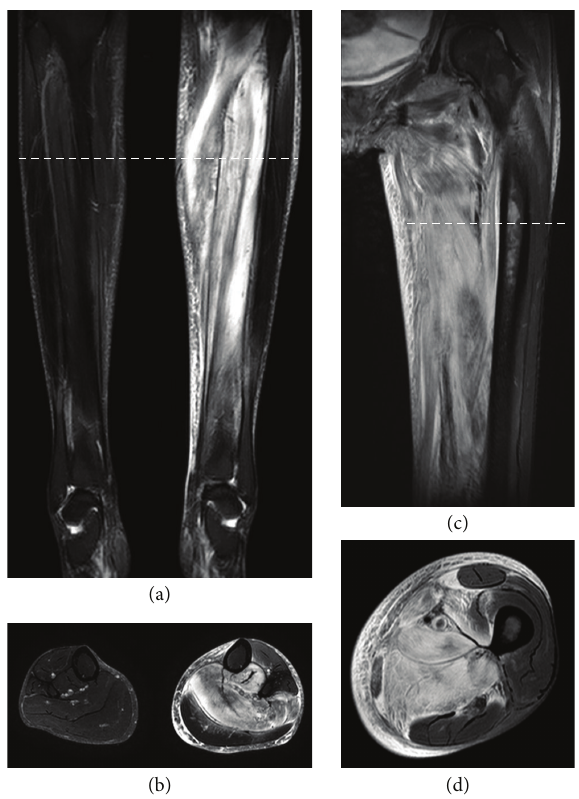
Figure 1: T2 weighted images with coronal (a, c) and axial (b, d) views for the 2 patients. The level of the axial views are indicated on the coronal images by the dashed lines. Images (a) and (b) show diffuse edema in the calf muscles of the left lower limb of the first patient, as illustrated by the hyperintense signal of the muscular tissue (note the normal low signal intensity of the muscles in the right leg). Images (c) and (d) show similar changes in the adductor muscles of the left upper leg of the second